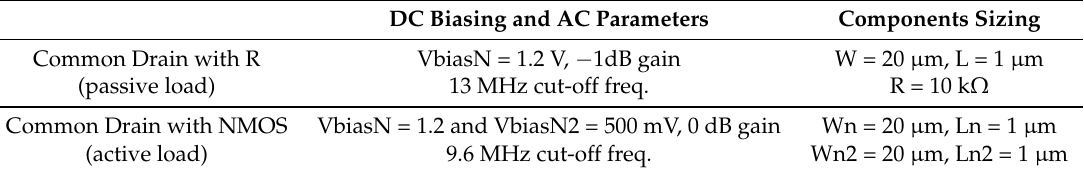
Table 2. DC and AC parameters and Transistor Sizing of the Common Drain Stage.